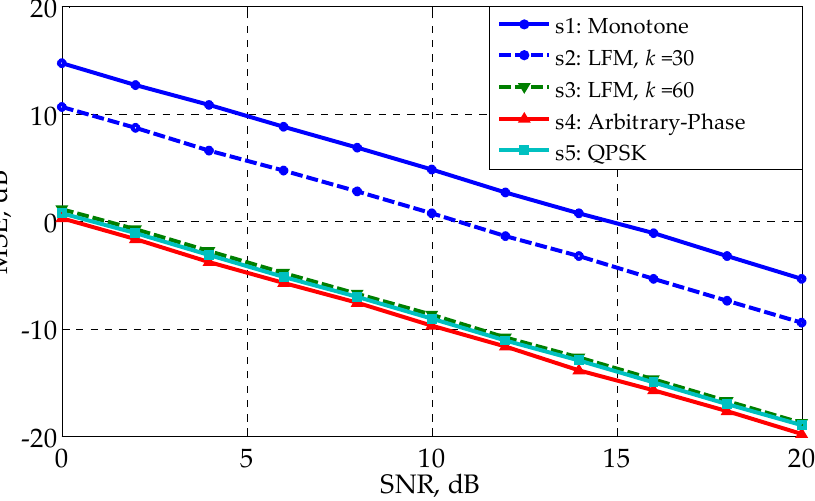
Figure 8. MSE (LS is used) versus SNR for different waveforms in the white noise.